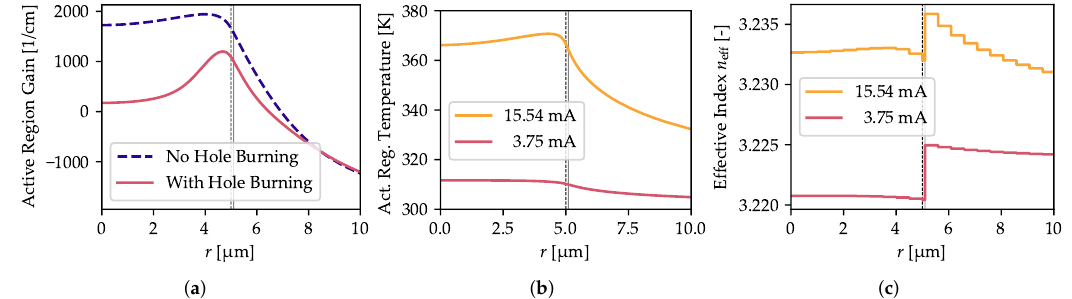
Figure 10. ( a ) Gain profile at 3.75mA with and without spatial hole burning. ( b ) Temperature profile in the active region for input currents of 3.75mA and 15.54mA. ( c ) Effective index distribution for the same input currents. For the lower current, the heating is low and the oxide island has the strongest impact on the effective-index distribution, while for the high current, thermal lensing has strength comparable to that of the oxide island. Visible staircase is a result of the numerical approximations used in our calculations. In all plots, black dashed and solid gray vertical lines indicate the outer aperture and the island radius,